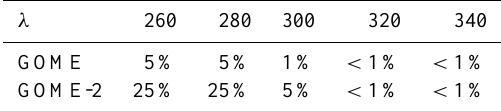
Table 3. Relative measurement noise in the level 1 data.